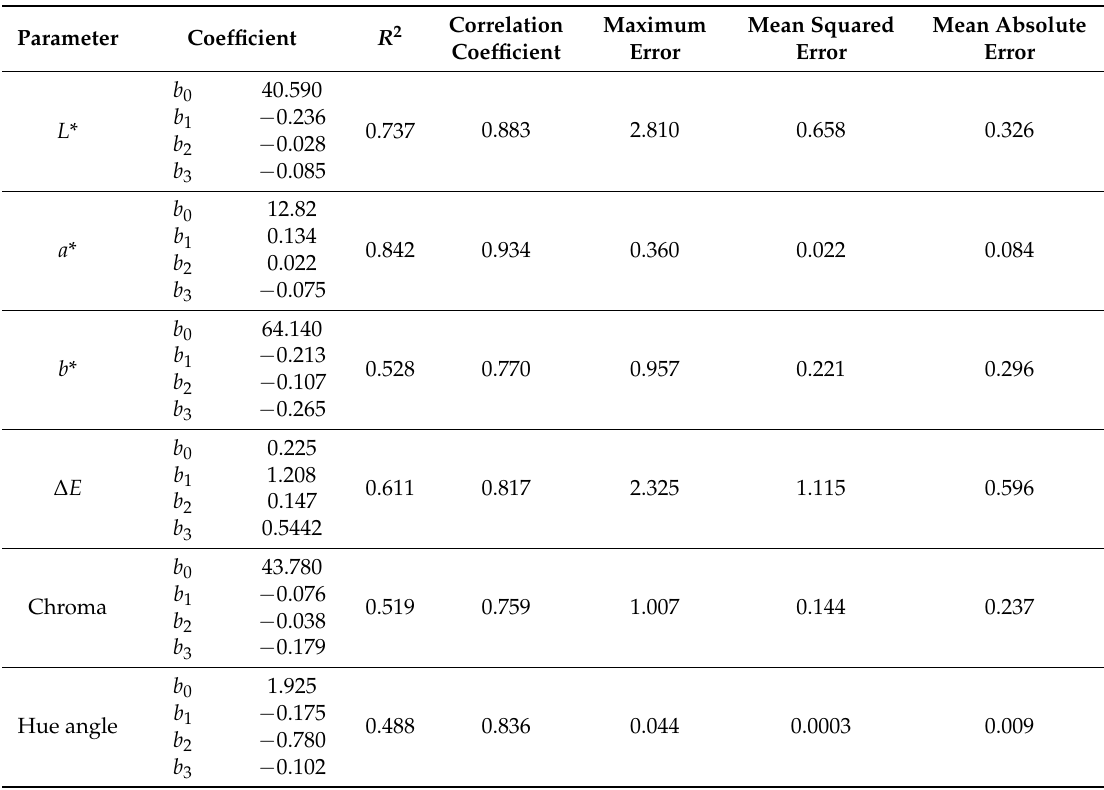
Table 2. Non-linear regression models coefficients for description of color component change